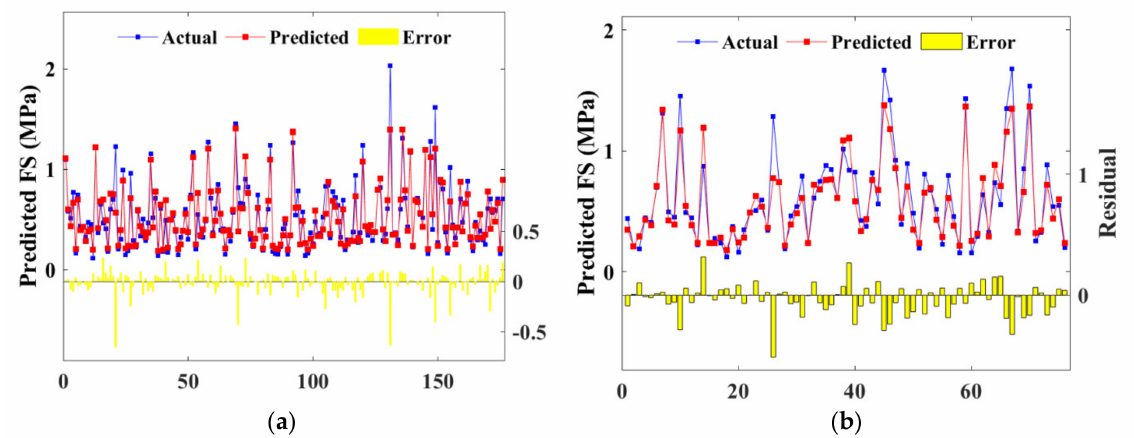
Figure 21. Scatter plot of predicted and actual FS of BPNN model: ( a ) training set; ( b ) test set.